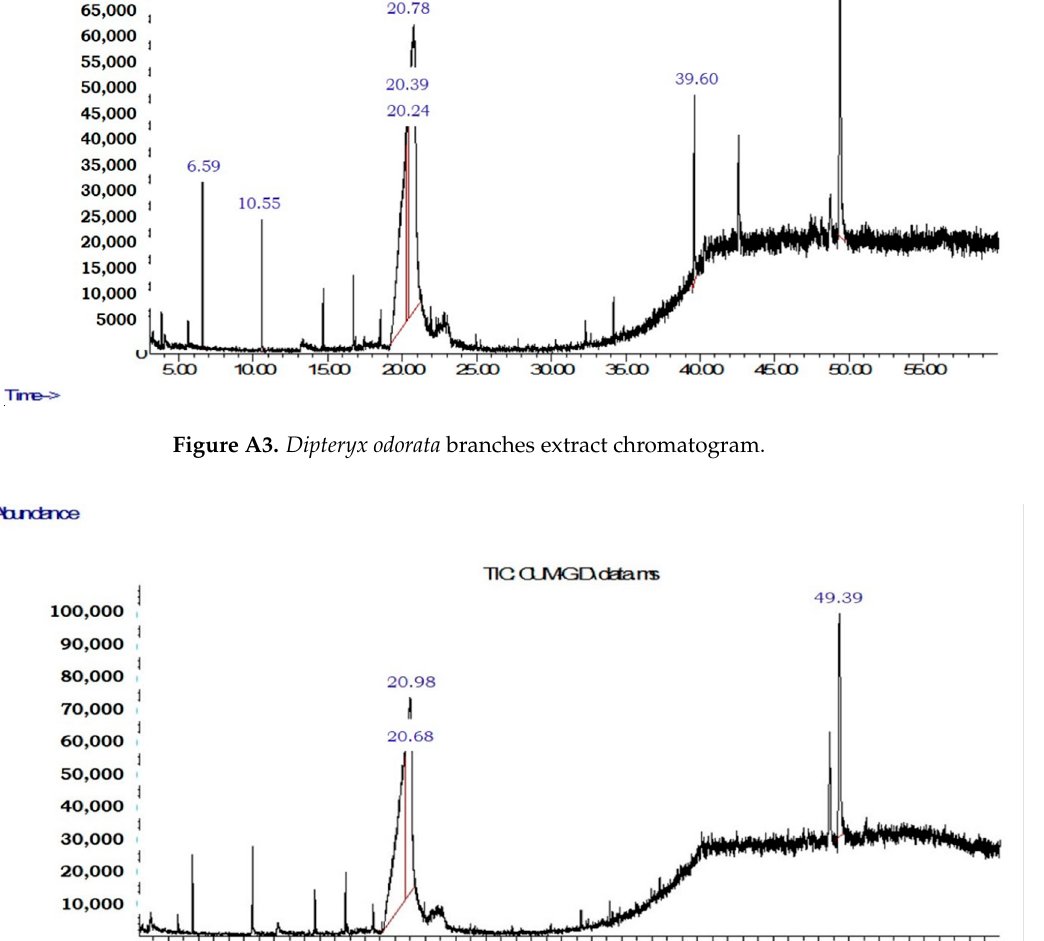
Figure A4. Dipteryx punctata branches extract chromatogram.